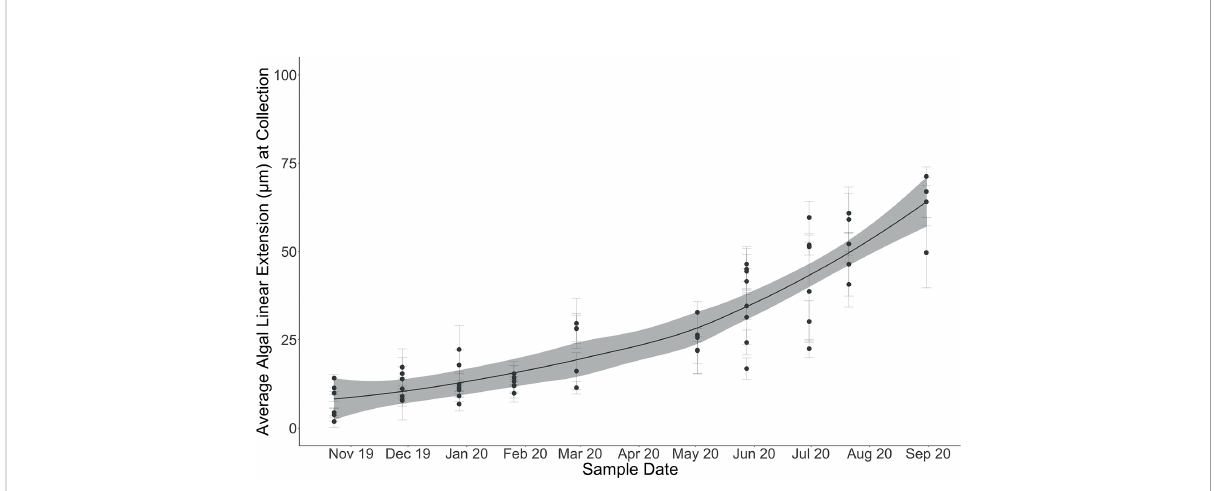
FIGURE 6 Average algal linear extension (µm) at each sample collection (October 28, 2019, through August 31, 2020). Error bars indicate standard error on mean algal linear extension computed from multiple linear extension measurements across individual algal surfaces. Locally weighted scatterplot smoothing (LOESS) model shown in solid line with shaded 95% con fi dence